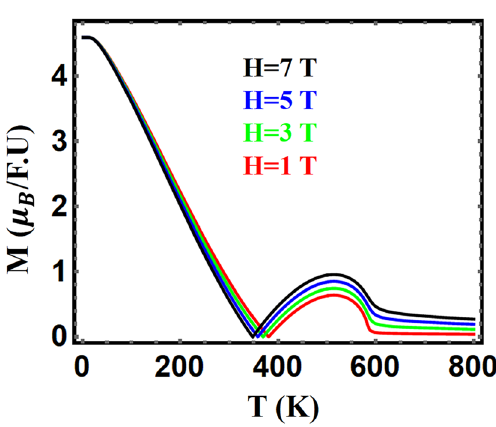
Figure 5. Total magnetization of HoFe 3 in different applied fields 1, 3, 5 and 7 T vs.